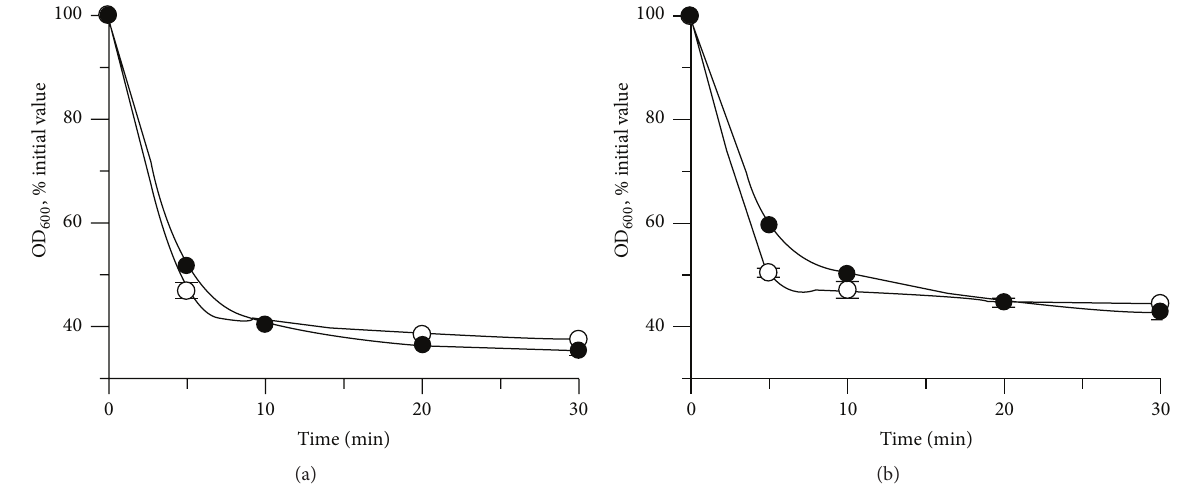
Figure 4: Activity of (a) PeiW and (b) PeiP in aerobic and anaerobic cell suspension assays. The assays were performed using Mtb. thermautotrophicus Δ H cells, as described in the Materials and Methods, e aerobic, I anaerobic. Initial OD 600 values were 0.771, PeiW aerobic; 0.865, PeiW anaerobic; 1.014, PeiP aerobic; 0.940, PeiP anaerobic. The total OD change of the enzyme-free and cell-free controls was less than 2% of the initial